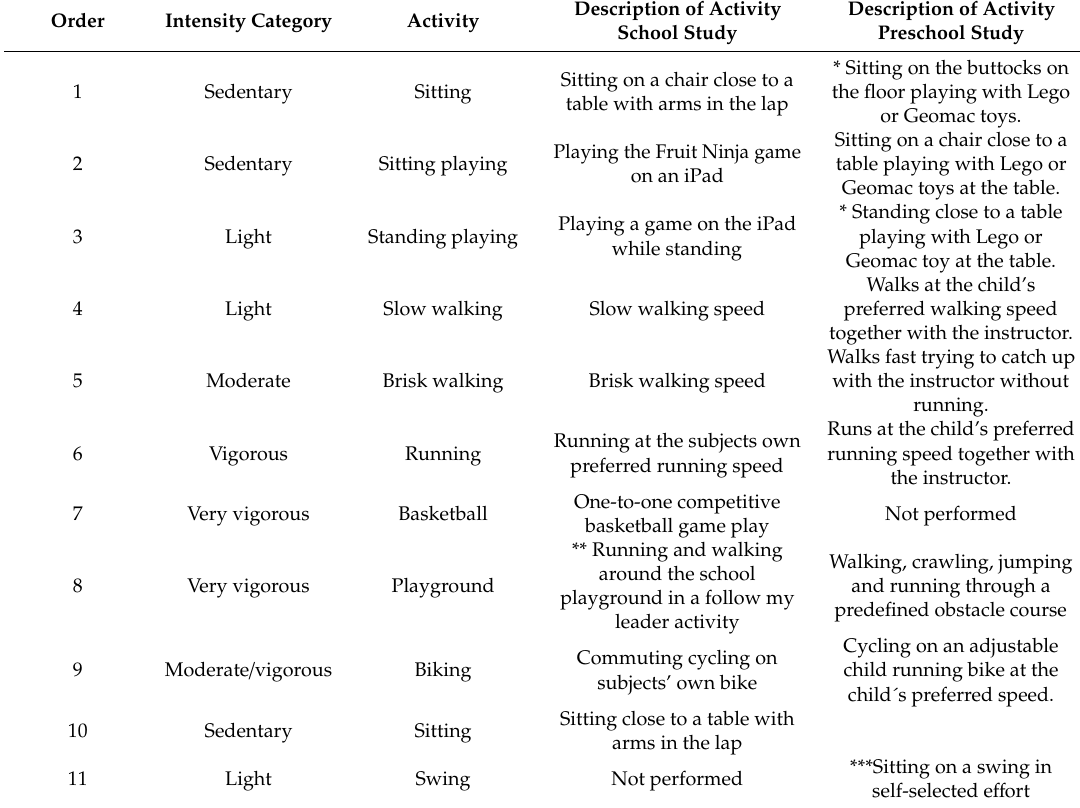
Table 1. Activities performed during the structured protocol at the school and preschool